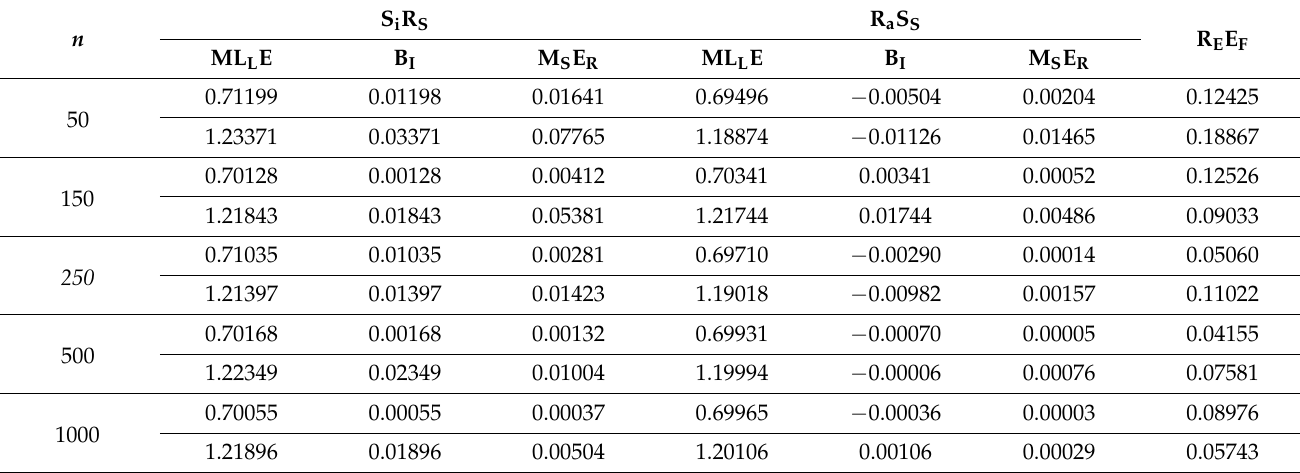
Table 2. The ML L E s , B I s, M S E R , and R E E F of the KMB X model under S i R S and R a S S at α = 0.7, β =